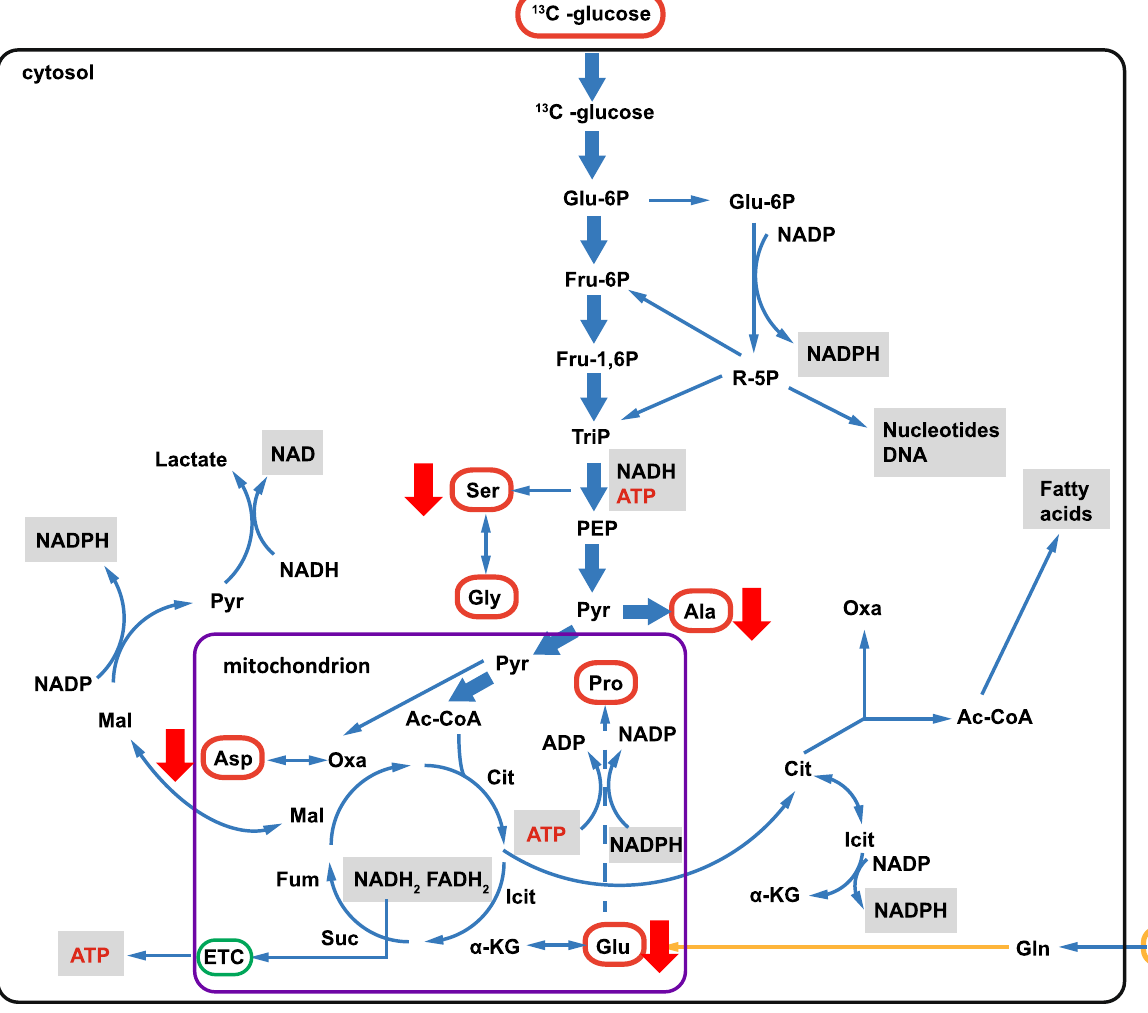
aspartate (Asp), glutamate (Glu), proline (Pro), serine (Ser), and glycine (Gly), with regard to enrichment of 13 C in mock-treated controls and cells incubated with 213 Bi-anti-EGFR-MAb. Results of 13 C-enrichment in EJ28Luc bladder cancer cells. Red arrows indicate significantly decreased enrichment of 13 C in 213 Bi-anti-EGFR-MAb treated cells compared to controls. ETC electron transport chain; (adapted from 4